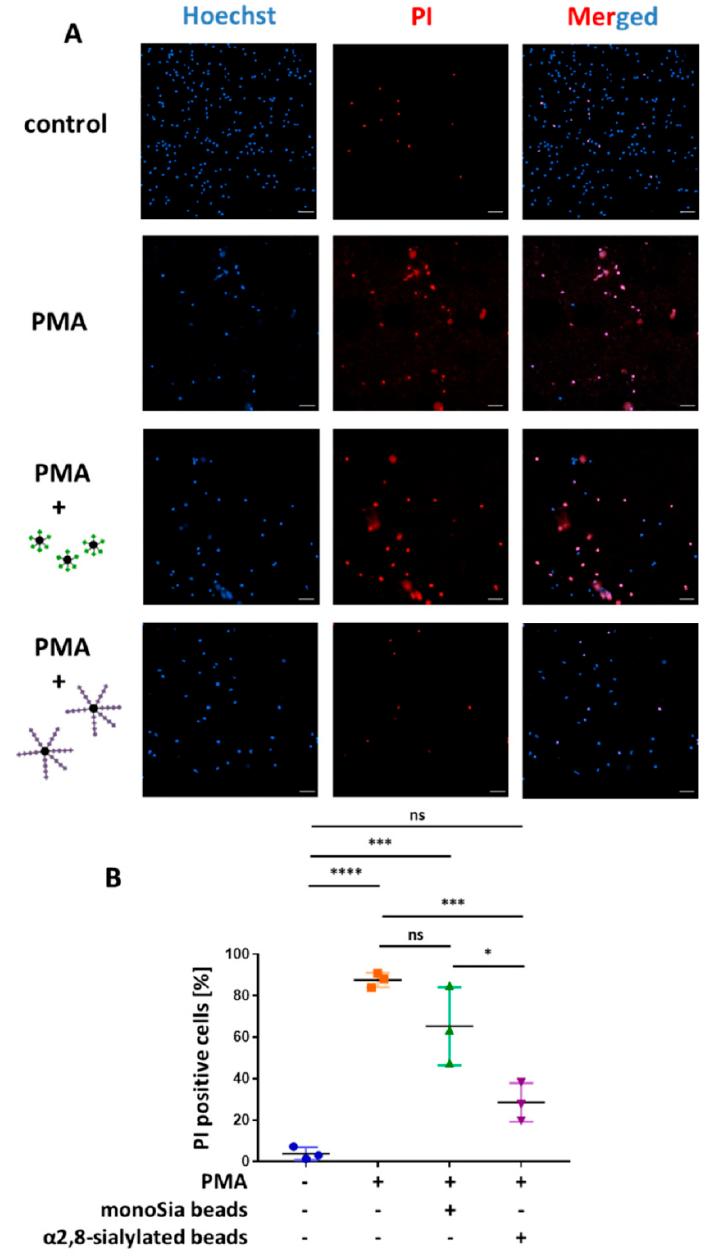
Figure 8. Coincubation of PMA-stimulated neutrophils with α 2,8-sialylated particles significantly decreases the number of PI-positive cells. ( A ) Isolated neutrophils stimulated with 20 nM PMA and isolated neutrophils stimulated with 20 nM PMA coincubated with α 2,8-sialylated particles or monosialylated particles were stained with PI (red) and Hoechst (blue) to determine membrane permeability. Unstimulated isolated neutrophils served as a control. Scale bars: 50 µ m. ( B ) Based on the fluorescence images the total number of cells was determined and was set in relation to the number of PI-positive cells. Mean values ( n = 3) and standard deviations are displayed in the diagrams. ANOVA and a multiple-comparison Tukey test were applied. Significant di ff erences are given as follows: ns, not significant, * p ≤ 0.05; *** p ≤ 0.001; and **** p ≤ 0.0001.